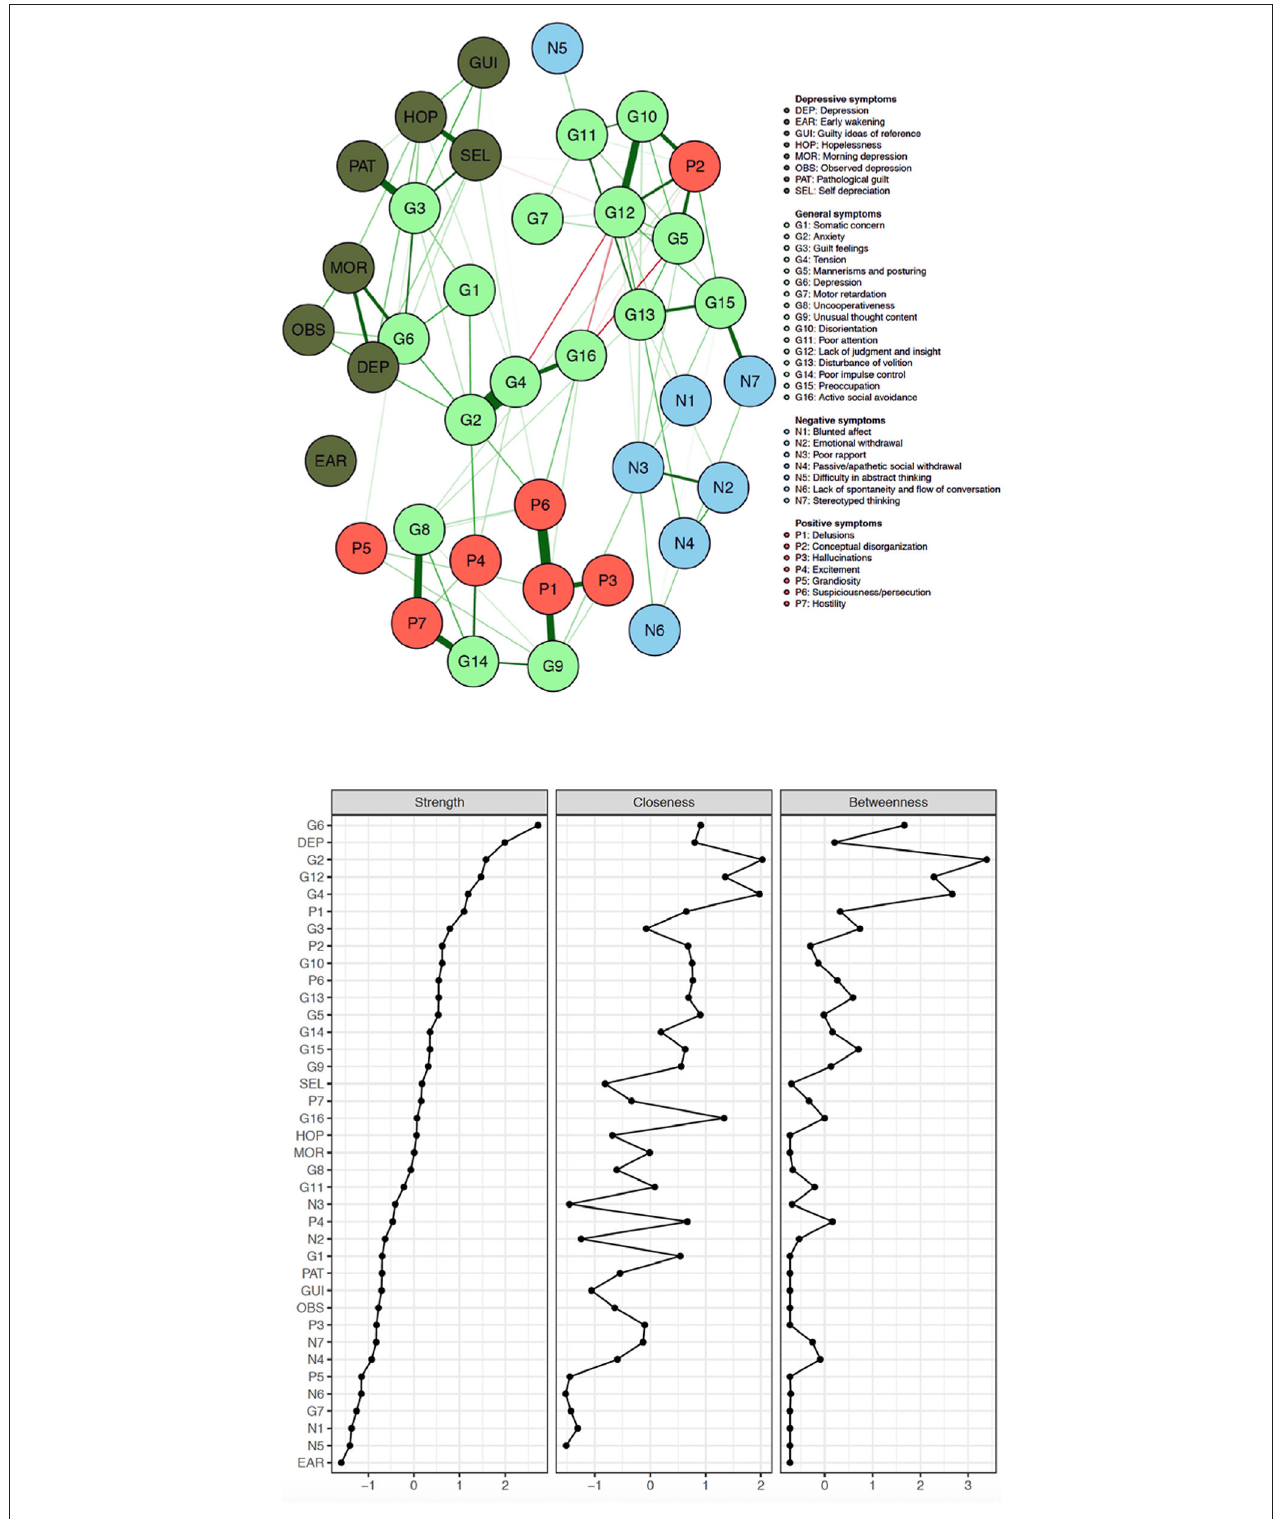
FIGURE 1 | Network of PANSS symptoms and CDSS symptoms in patients with persistent and predominant negative symptoms (red, positive symptoms; blue, negative symptoms; pale green, general symptoms; dark green, CDSS symptoms).